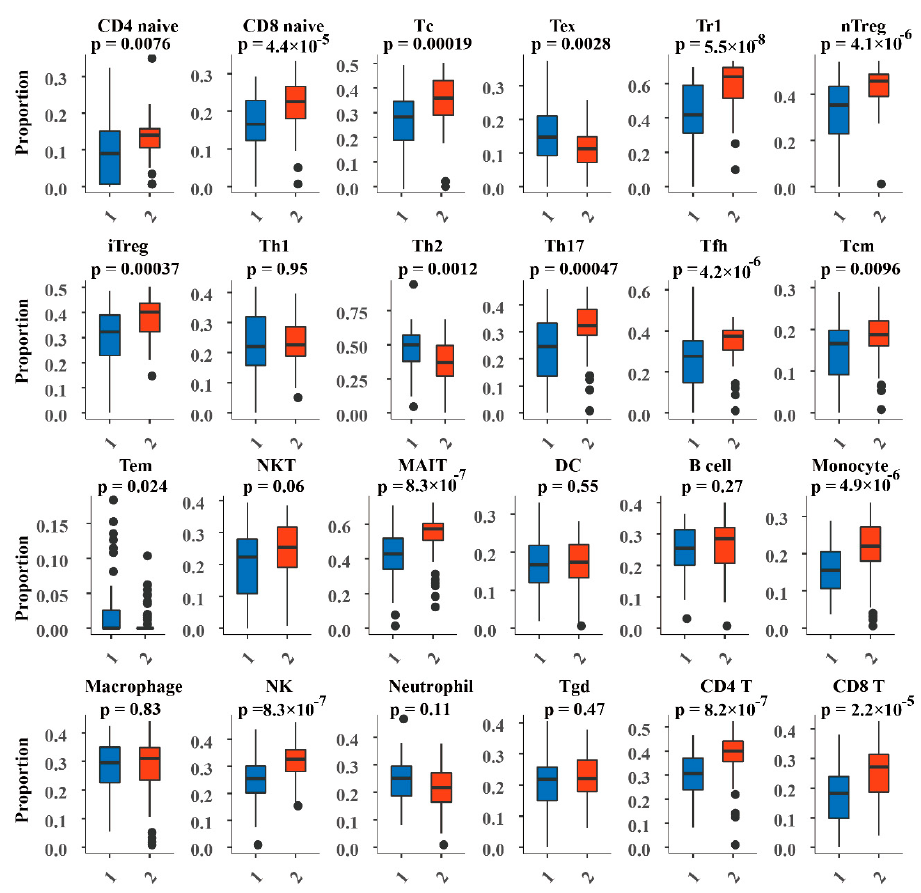
Figure 5. Abundance of 24 immune cells in Cluster1 and